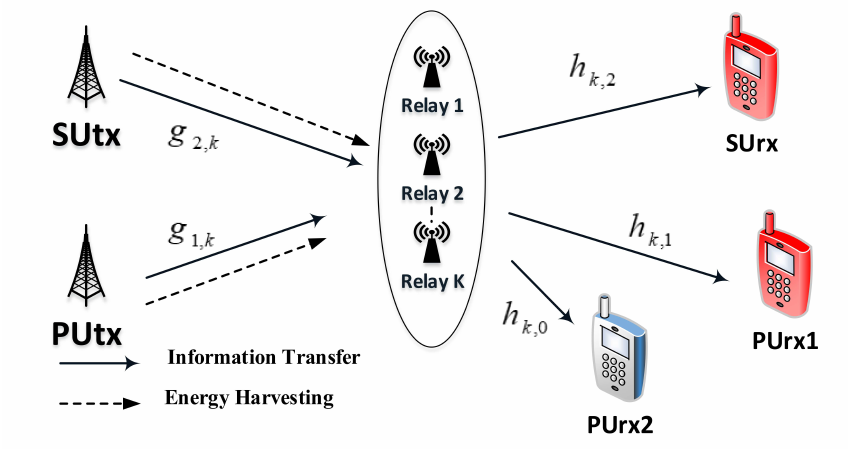
Figure 2. Scheme 2: Multiple relays in EH assisted CR-NOMA